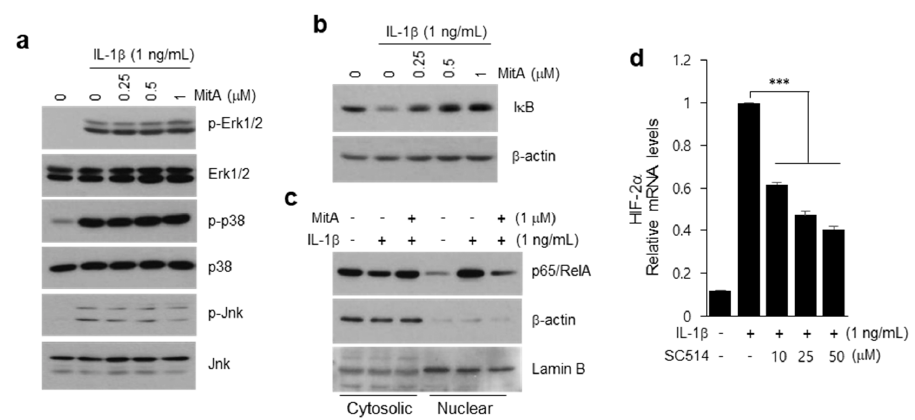
Figure 5. IL-1 β -induced activation of NF- κ B, but not MAP kinases, is inhibited by MitA in chondrocytes. ( a – c ) chondrocytes were pre-treated with MitA for 24 h and subsequently treated with IL-1 β for 10 min. ( a ) MitA does not inhibit activation of MAP kinases. Activations of MAP3 kinases, Erk, p38, and Jnk were determined by Western blotting with phospho-antibodies; ( b , c ) MitA suppresses degradation of I κ B and translocation of NF- κ B; ( b ) Degradation of I κ B was determined by Western blotting; ( c ) Nuclear translocation of p65/RelA was determined by subcellular fractionation and Western blotting. β -actin and Lamin B were used as markers of cytoplasmic and nuclear fractions, respectively; ( d ) Inhibition of HIF-2 α expression by SC514, an IKK β inhibitor, in IL-1 β -treated chondrocytes ( n = 4). Values are means ± SEM (*** p < 0.001).